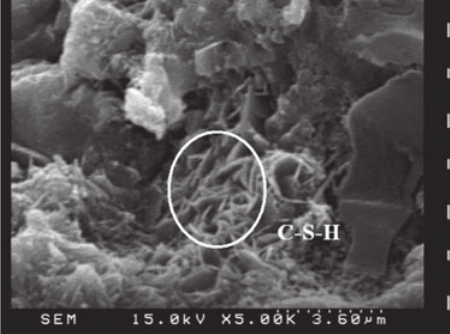
Figure 7 SEM image of specimen with 10 % bagasse ash ( ×